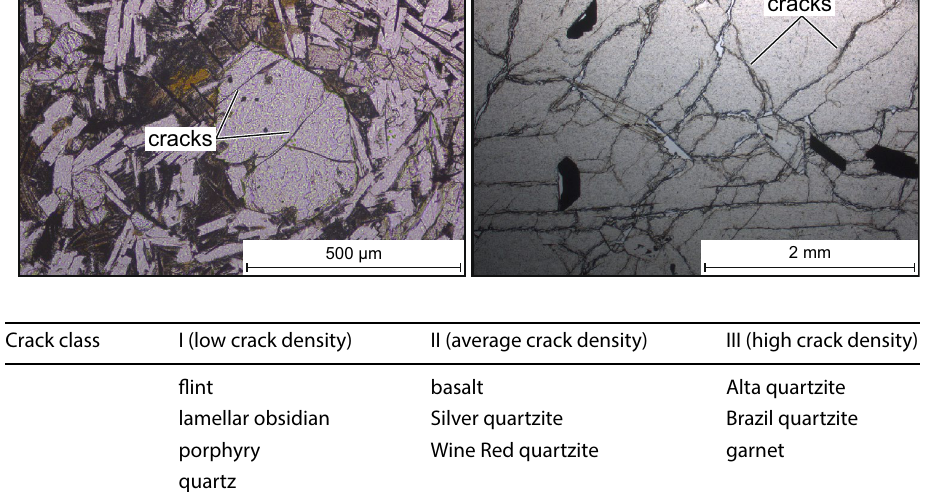
Fig. 5 Examples for cracks in the microstructure of the rocks shown using thin sections